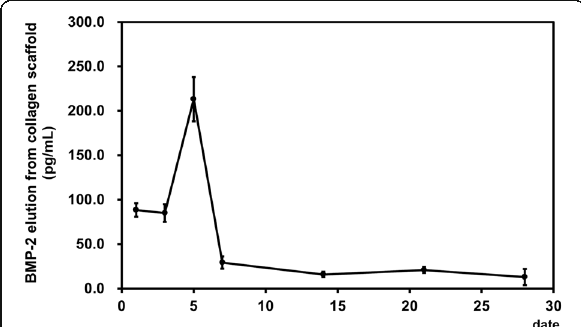
Fig. 3 Time course of the rhBMP-2 protein secretion quantified by measuring the BMP-2 elution from BMP-2-loaded collagen scaffold